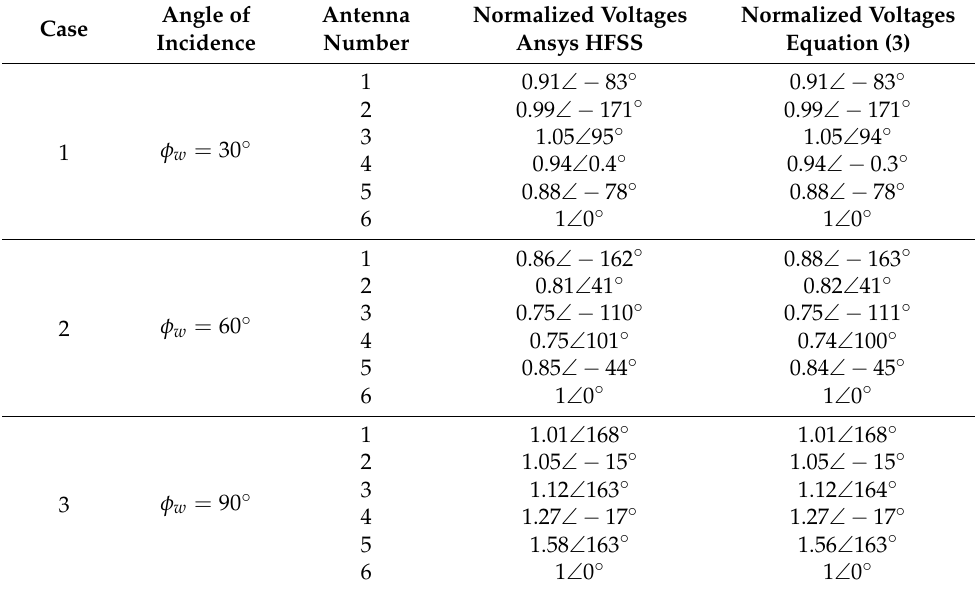
Table 2. Comparison between voltages computed with (3) and with Ansys HFSS. Angle of Case